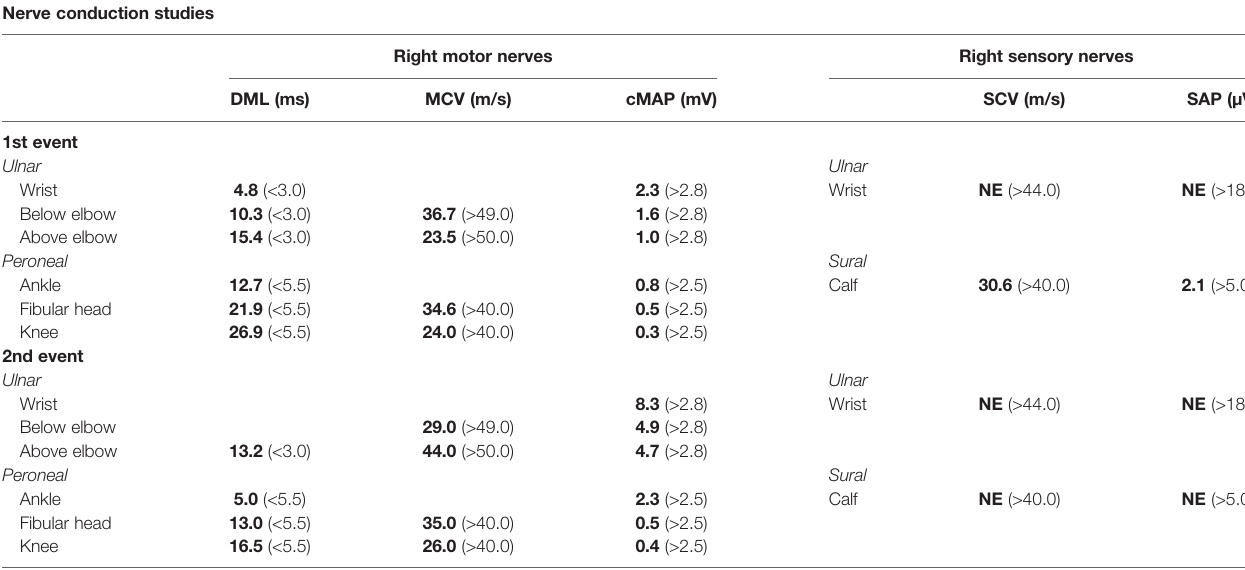
TABLE 2 | Electrophysiology performed during the fi rst (post-COVID-19 GBS) and second events (post-COVID-19 vaccine GBS recurrence). Nerve conduction studies Right motor nerves Right sensory